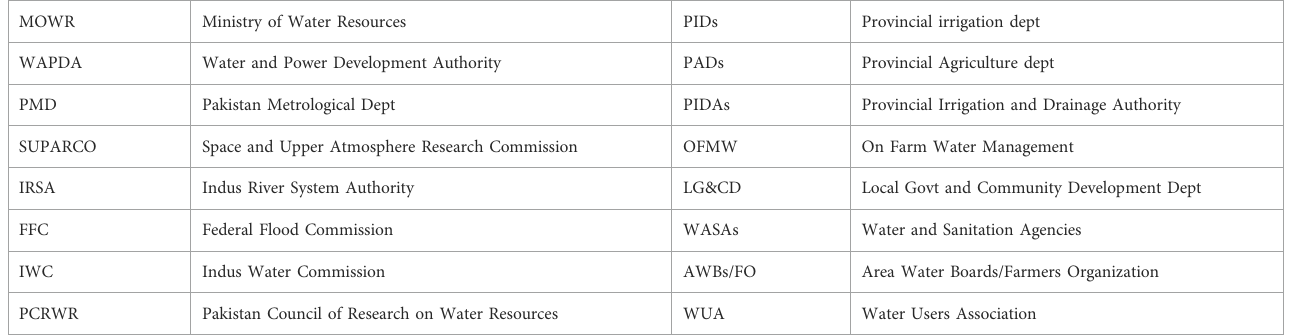
TABLE 2 Pakistan ’ s water resource management